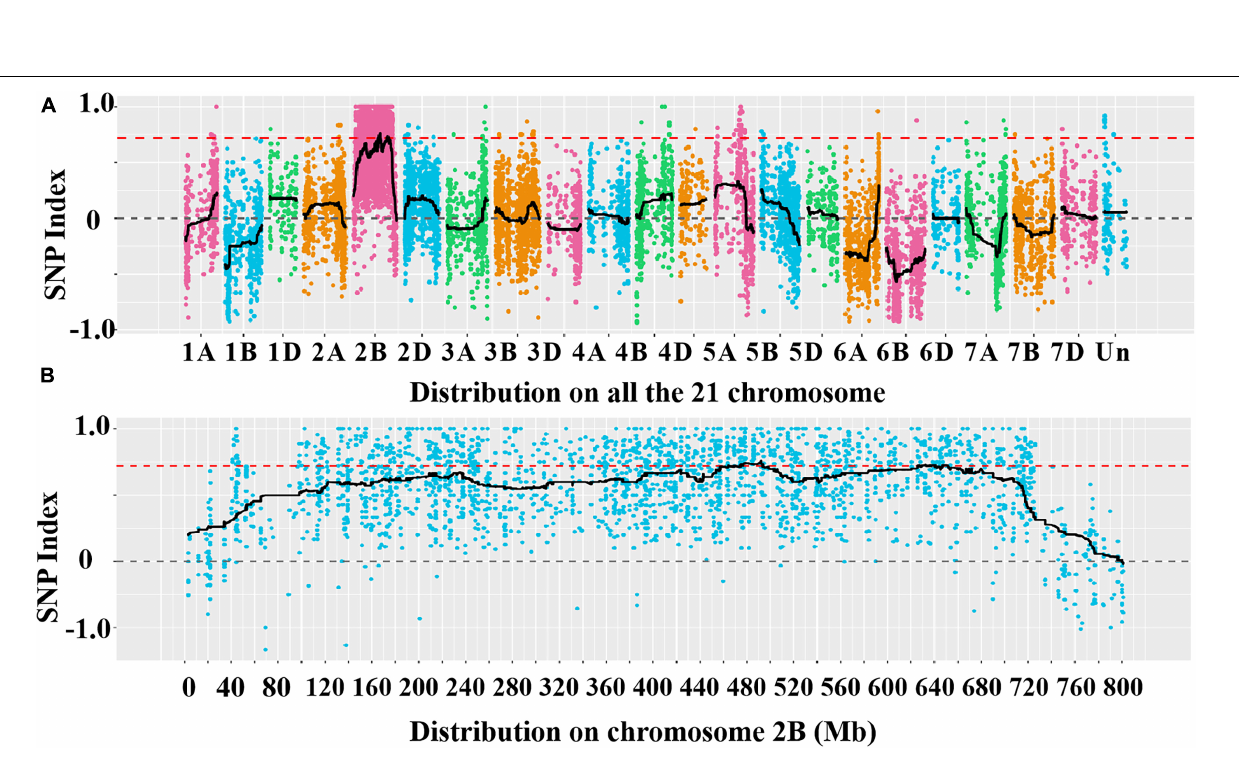
Frontiers in Plant Science |